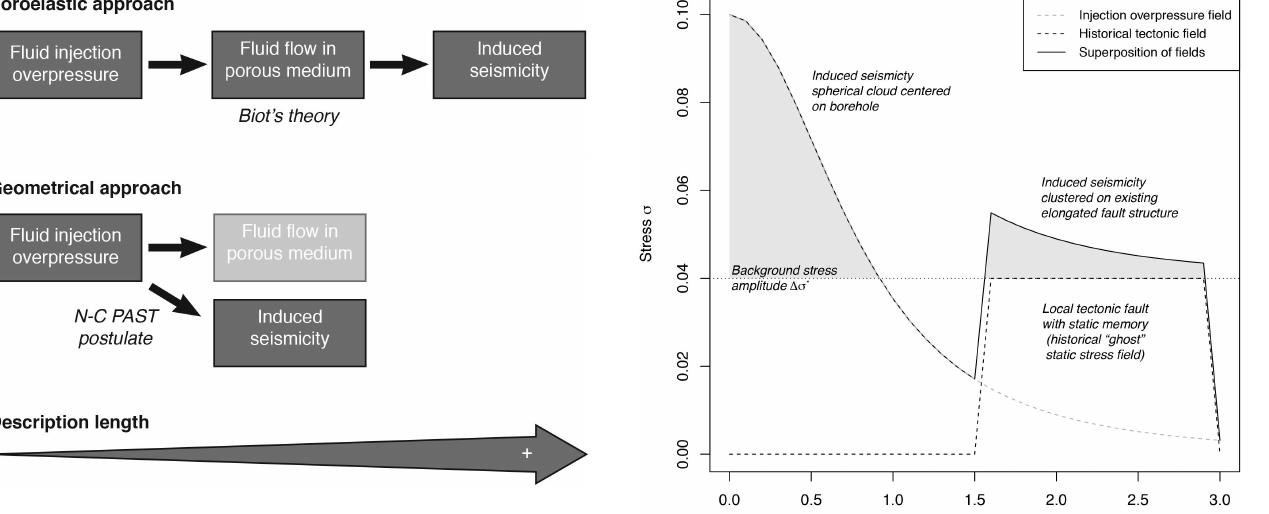
Figure 4. Description length defined as the count of physical steps required to describe induced seismicity, in poroelasticity and in the newly proposed geometrical approach. In the latter, Biot’s theory is entirely bypassed.